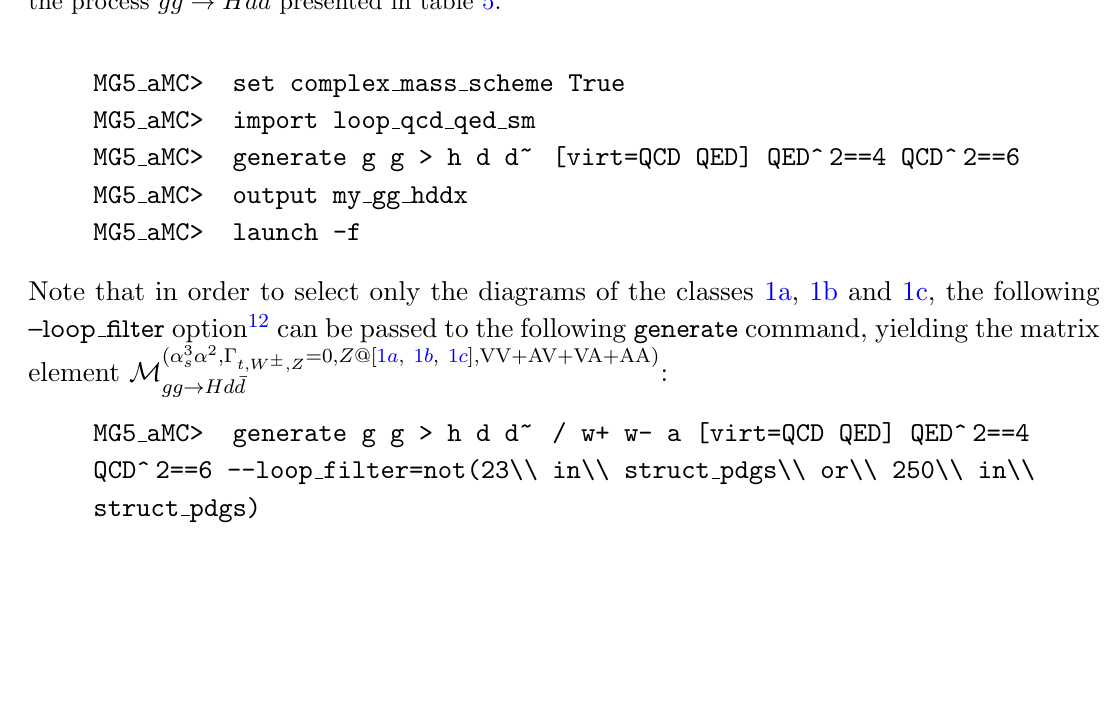
(cid:0) (cid:1) (cid:11) 2 (cid:11) 3 contribution to s O